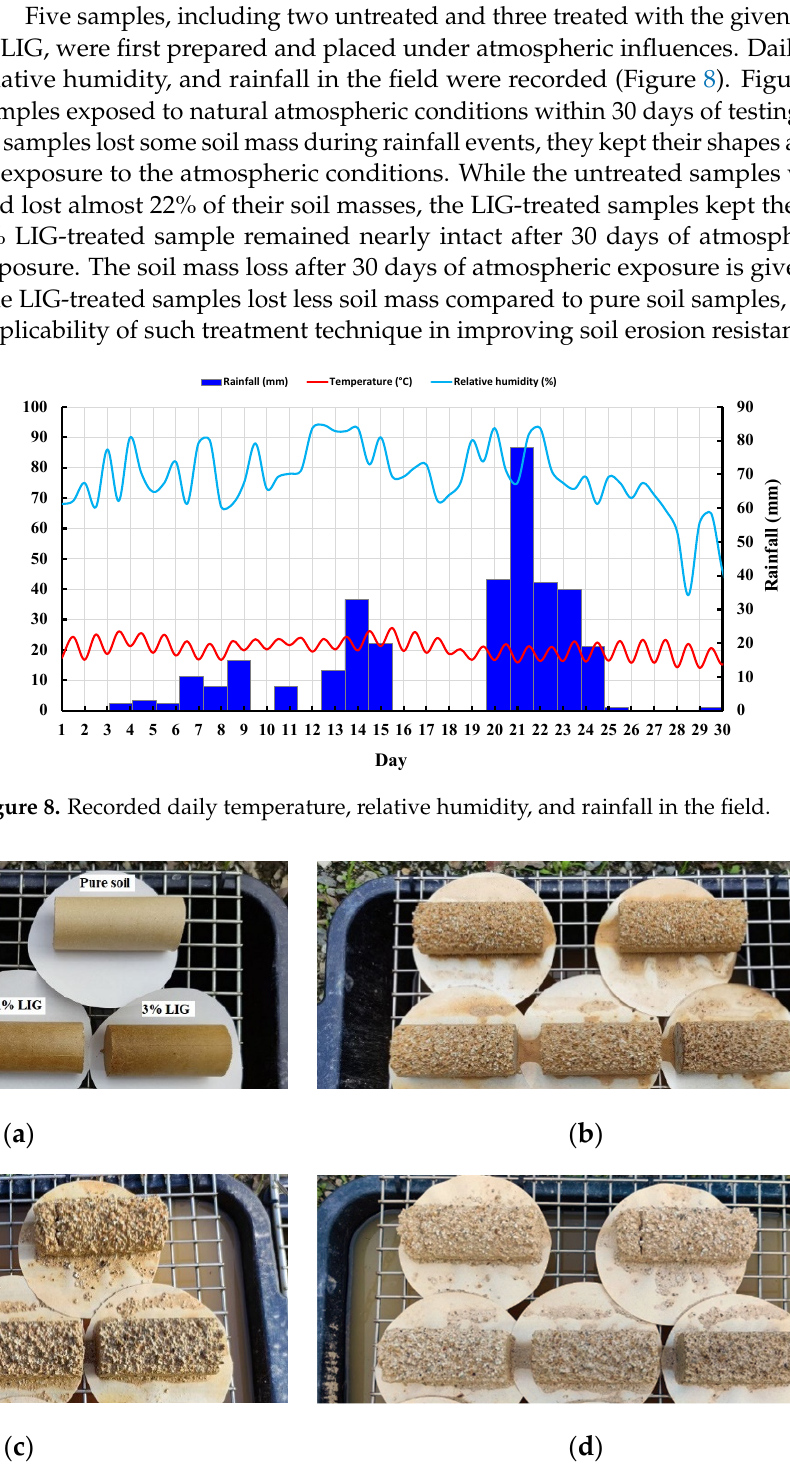
Figure 9. Samples exposed to the atmospheric conditions at ( a ) day 1, ( b ) day 14, ( c ) day 21, and ( d ) day 28.